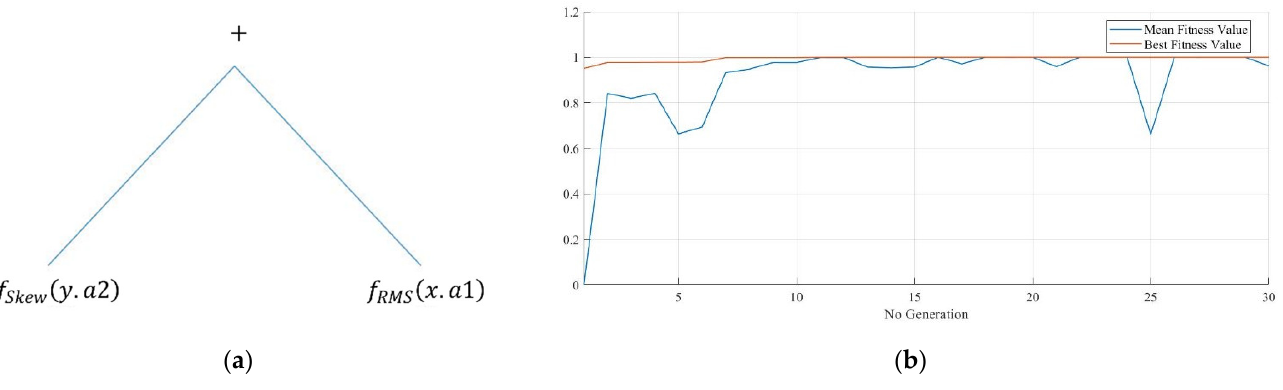
Figure 4. Classification-based GP results: ( a ) The tree representing the constructed features, and ( b ) the mean and the best fitness values at each GP iteration.